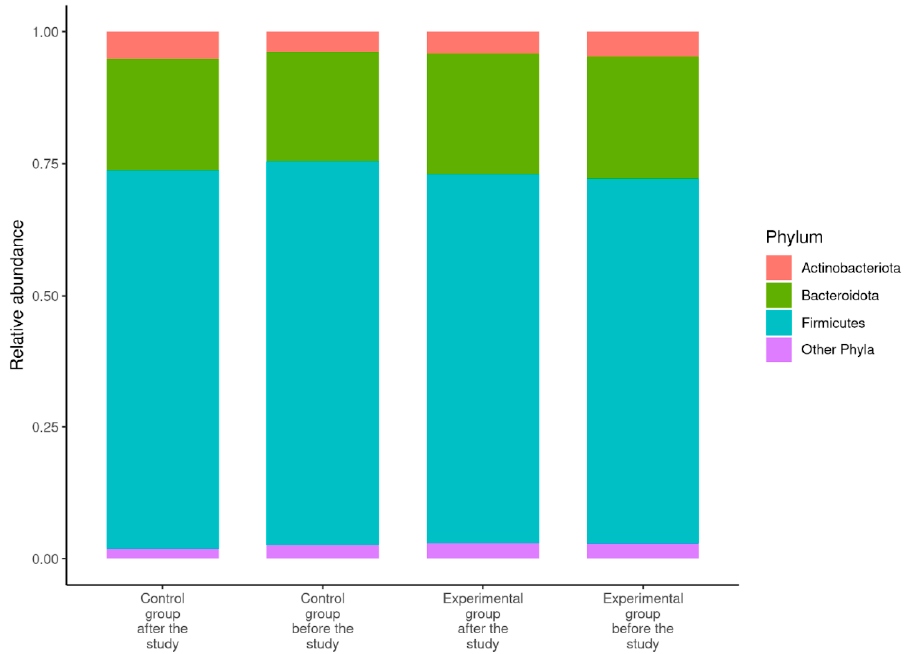
Figure 1. The average gut microbiome composition at the phylum level among study participants ( n = 52). Phyla with relative abundance below 2% were collapsed in order to avoid cluttering the graph.